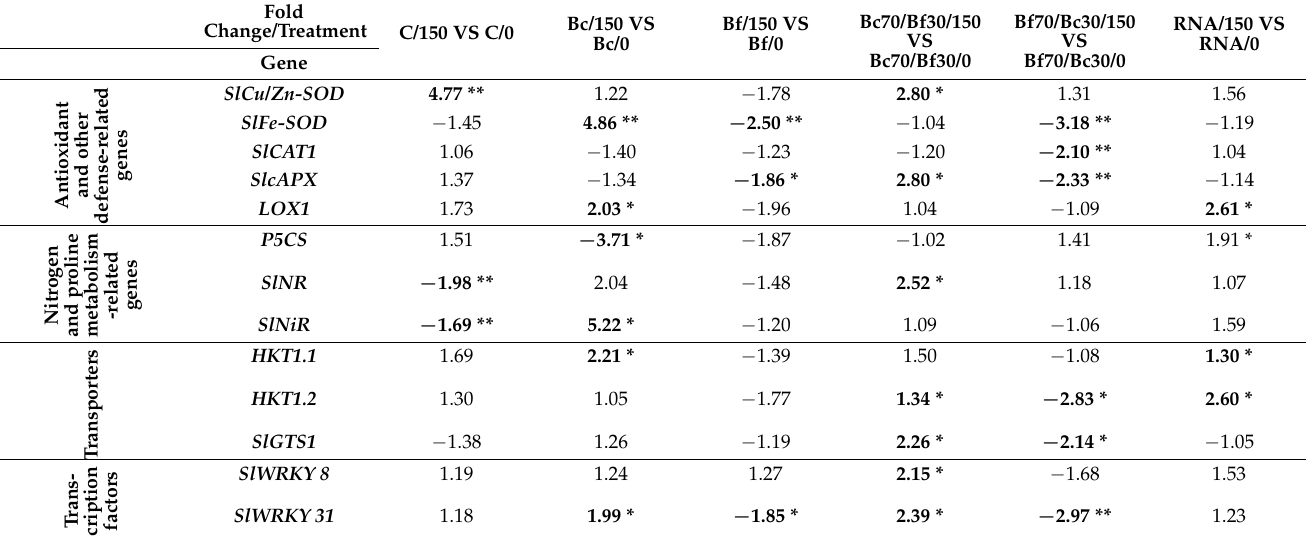
Table 2. Gene expression analysis of selected genes associated with RONS and proline metabolism, enzymatic antioxidants, transporters, lipoxygenase, and salt stress-responsive transcription factors. The numbers represent the fold change (FC) of the genes under salinity (150 mM NaCl) vs. the non- stressed (0 mM NaCl) conditions for each treatment. Bold letters indicate a statistically significant difference at levels p < 0.05 = 1 asterisk *, p < 0.001 = 2 asterisks **. Treatment abbreviations are explained in Figure